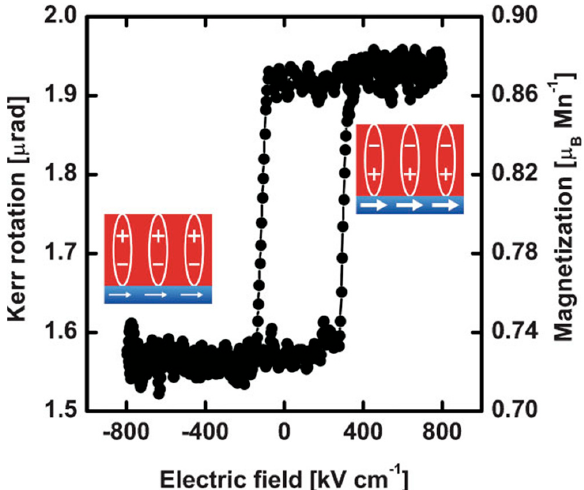
Figure 5. ME hysteresis loop at 100 K demonstrating the applied electric field dependence on the magnetic behavior of the PZT/La 0.7 Sr 0.3 MnO 3 (LSMO) heterostructure. The two magnetization values indicating the modulation of the magnetization values of LSMO layer (Insets: the FE and magnetic states of the PZT and LSMO layers respectively. The size of the white arrows implies the amplitude of magnetization qualitatively). Figure reproduced with permission from [54] .